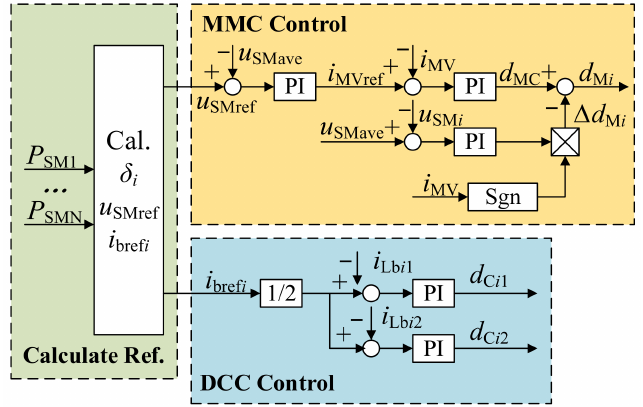
Figure 2. Block diagram of